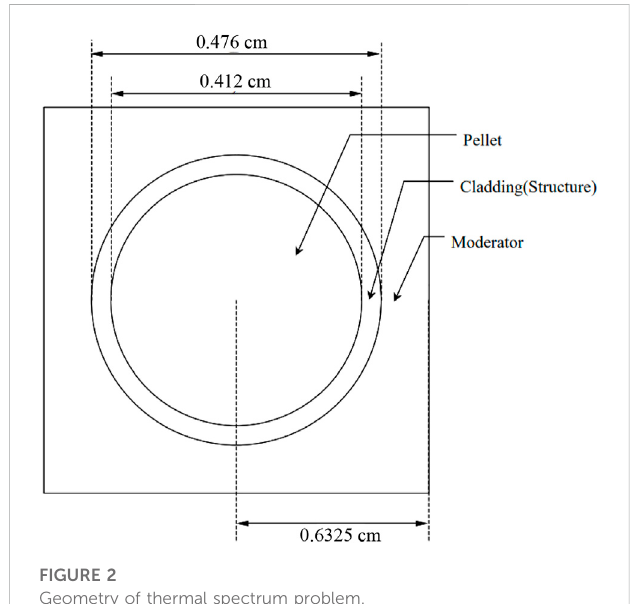
Frontiers in Energy